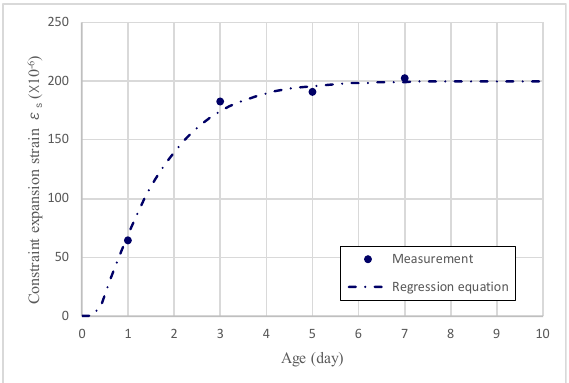
Figure 11. Restraint expansion test.